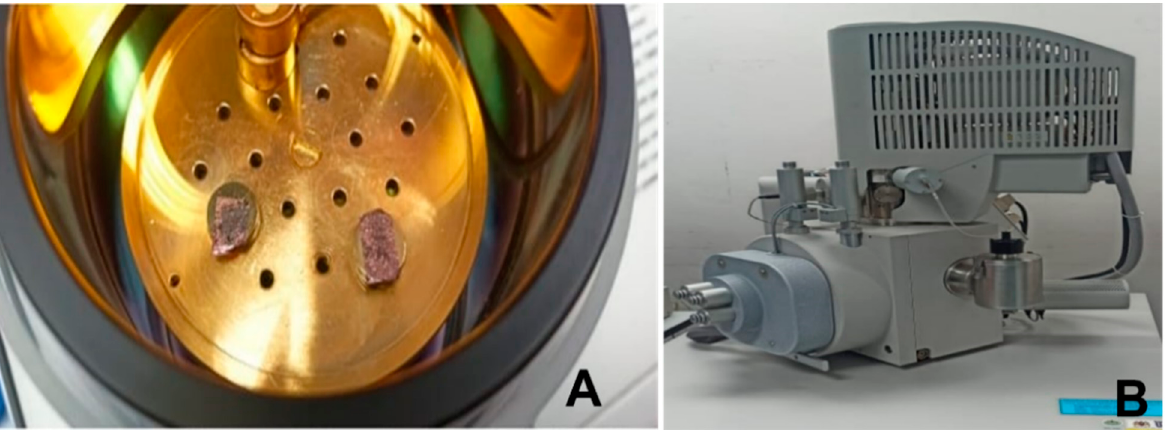
Figure 2. ( A ) Gold plating of samples and the ( B ) scanning electron Figure 2. A. Gold plating of samples and the B. scanning electron microscope .